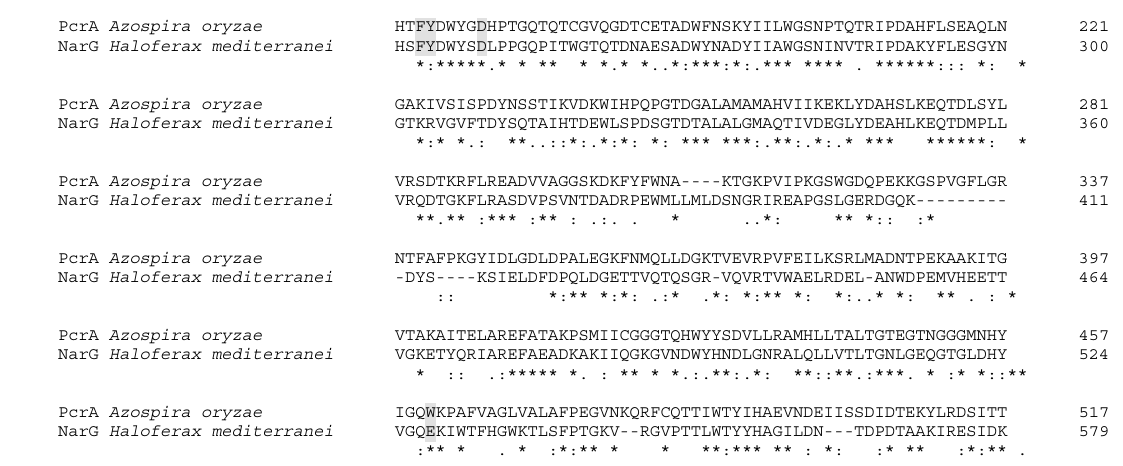
Figure 8. EMBOSS Needle alignment of PcrA ( A. aryzae) with NarG ( H. mediterranei ). In grey are the residues of the hydrophobic tunnel of each enzyme. Trp461 from PcrA changes to Glutamate in NarG.